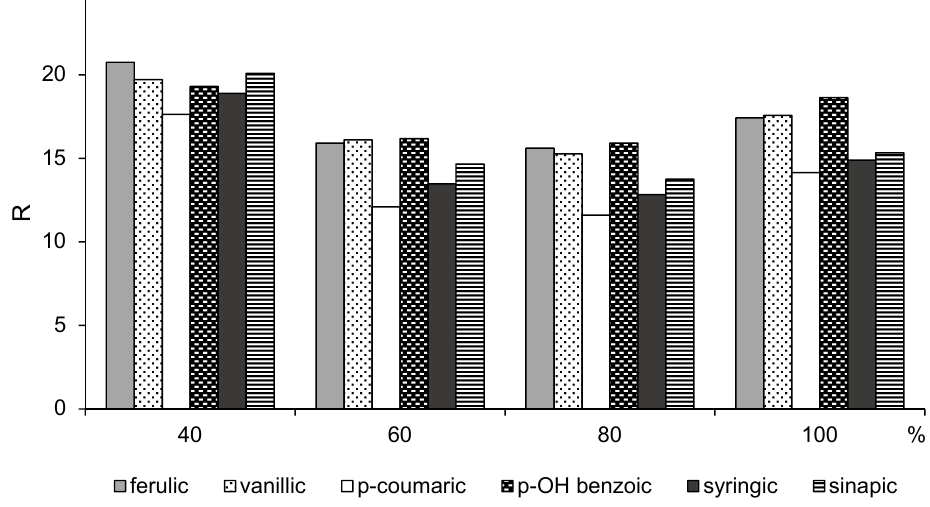
Figure 2. Hansen solubility parameter distances (R) between phenolic acids and 40%, 60%, 80%, and 100% acetone.